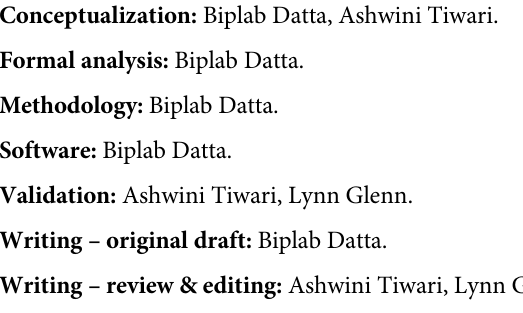
S3 Table. Adjusted relative risk ratios in favor of mutually exclusive high blood pressure and high blood glucose outcomes for adolescent motherhood and sociodemographic corre- lates. Estimates were obtained using complex survey weights. ��� p < 0.01, �� p < 0.05. 95% confidence intervals are in parenthesis. S4 Table. Adjusted relative risk ratios in favor of mutually exclusive high blood pressure and high blood glucose outcomes for adolescent motherhood, sociodemographic corre- lates, and hypertension and diabetes risk factors. Estimates were obtained using